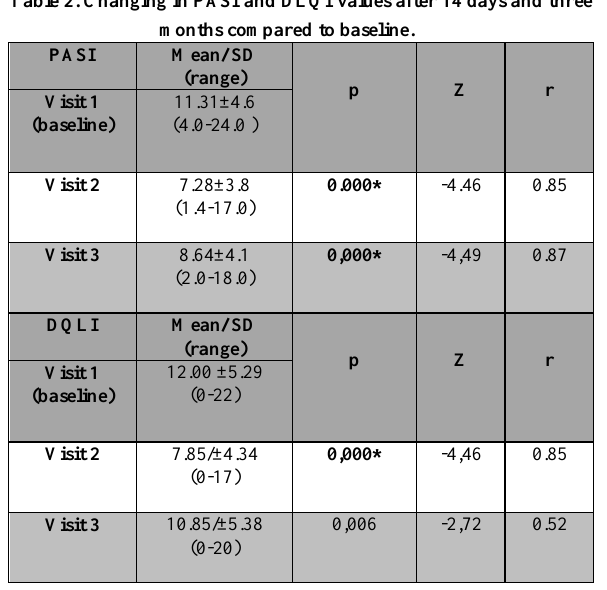
Fig. 2. Changes flow in disease activity and quality of life three times, measured by PASI and DLQI, respectively. Table 2. Changing in PASI and DLQI values after 14 days and